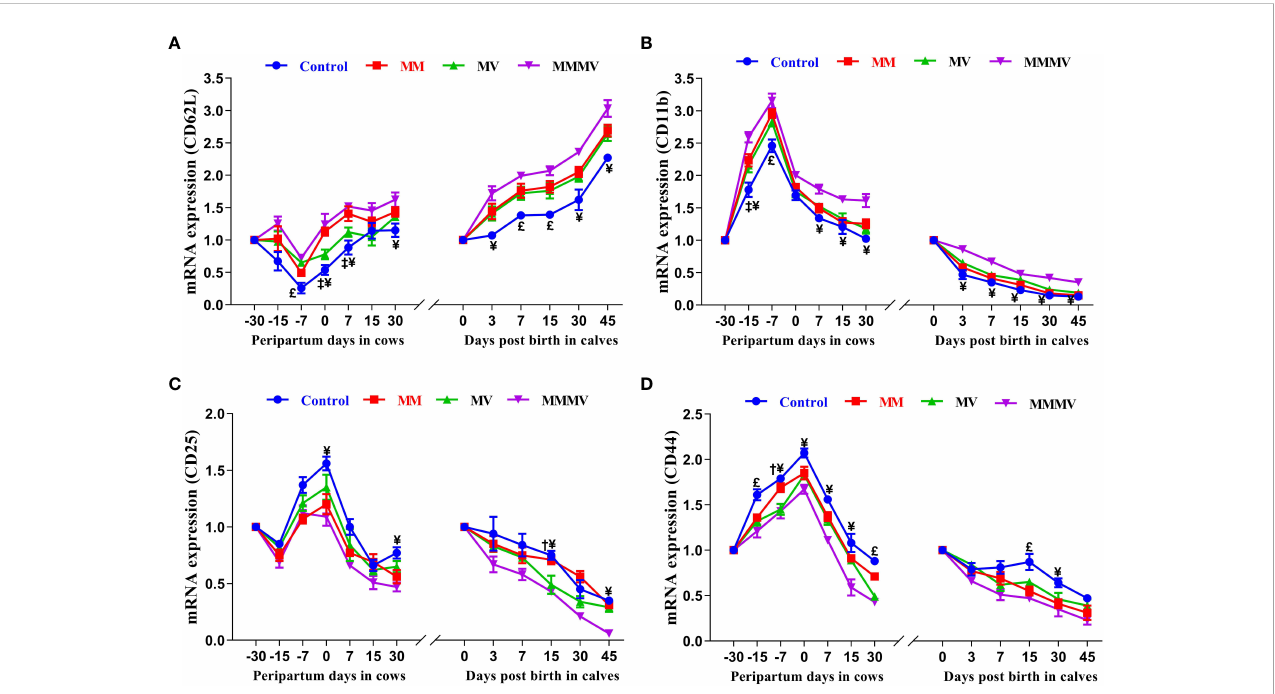
FIGURE 5 Relative mRNA expression of CD62L (A) , CD11b (B) , CD25 (C) , and CD44 (D) in blood neutrophils of control and treatment groups of crossbred cattle and their calves. Control: received basal diet only, MM: basal diet + injectable multimineral, MV: basal diet + injectable multivitamins, MMMV: basal diet + combination of injectable multimineral and multivitamins. The mean values with different superscript symbols represent signi fi cant differences with the control group at different days of peripartum in cows and post birth in calves; ‡ Control Vs MM, † Control Vs MV, ¥ Control Vs MMMV. £ Control Vs MM, MV and MMMV. b -actin and GAPDH were used as endogenous genes and the mRNA abundance of the day -30 for cows and day of birth for calves was taken as a calibrator with which relative expression of all genes during different time points was